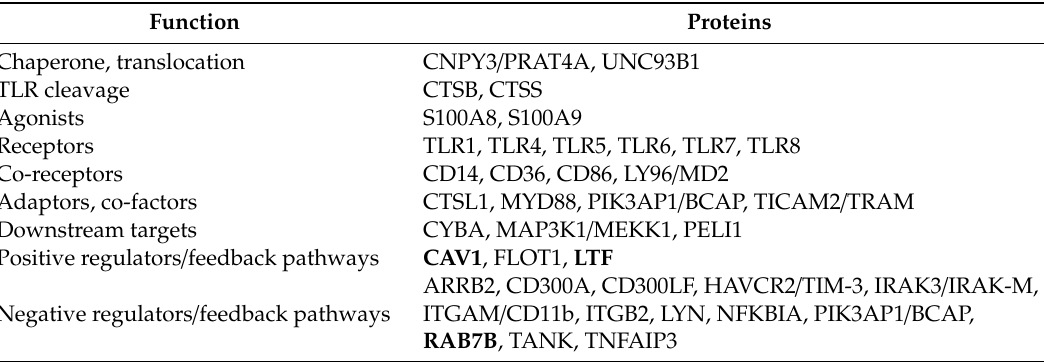
Table 2. Overview of the 38 di ff erentially expressed mRNA levels of proteins belonging to the GO-term “TLR signaling” and their function in the TLR pathway. The three proteins in bold were found to be overexpressed in the patient subset with reduced response towards TLR